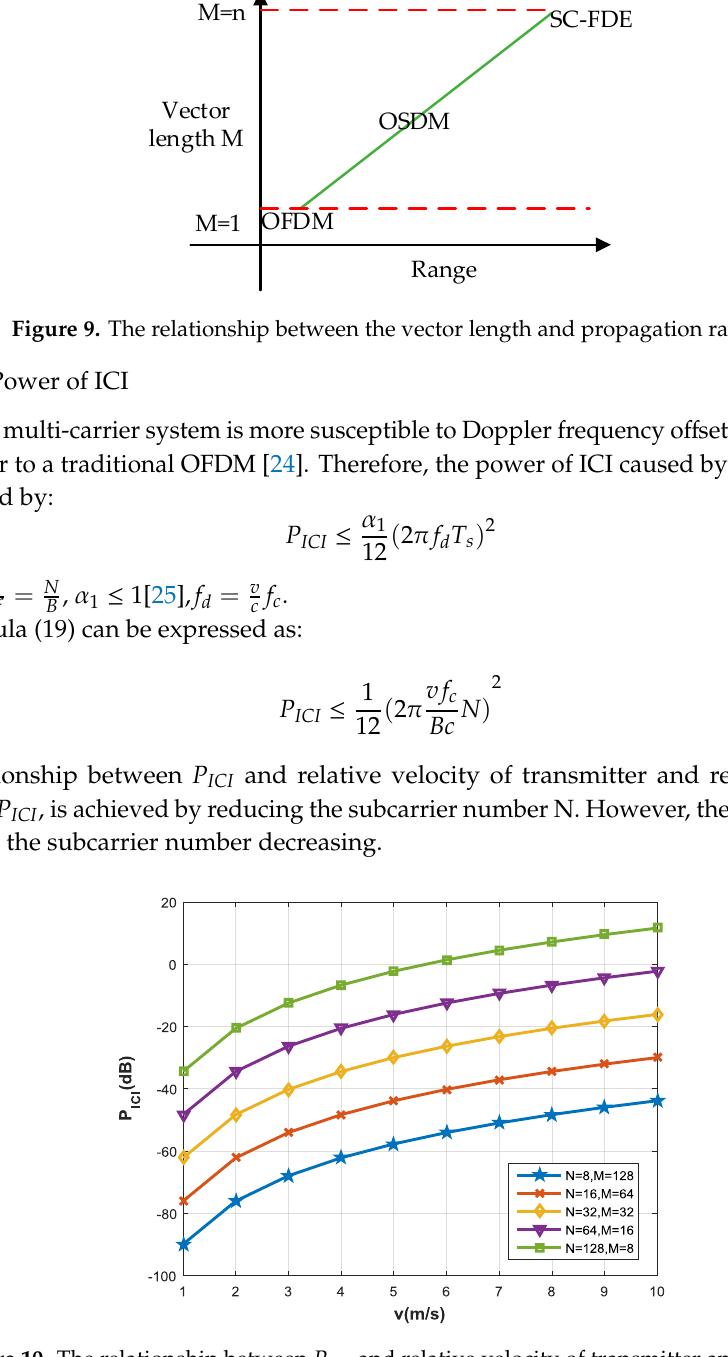
P and relative velocity of transmitter and receiver.